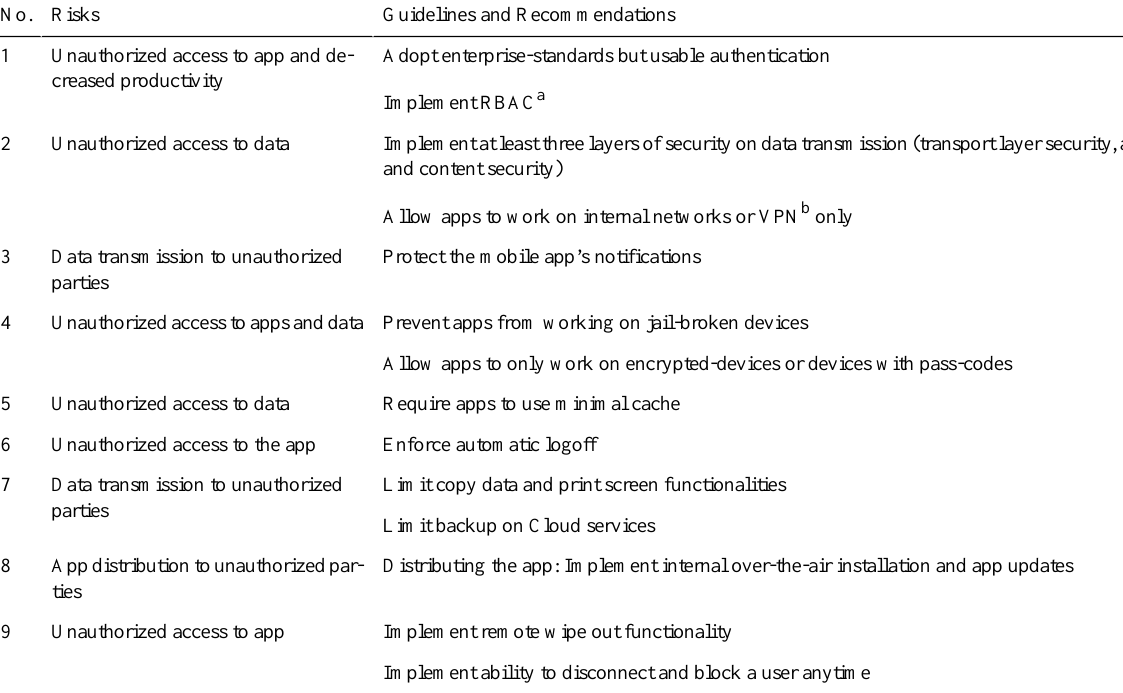
Table 1. Summary of BCH BYOD guideline to safeguard custom application in hospital settings. Guidelines and